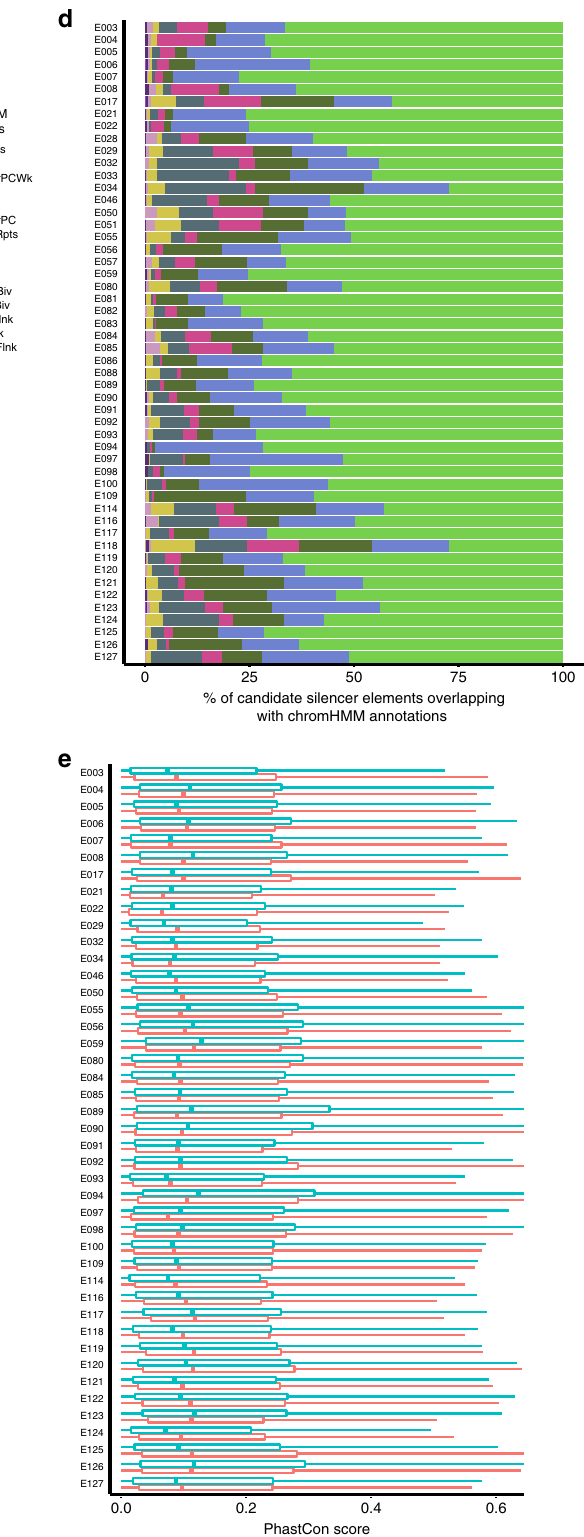
Fig. 4 Characteristics of candidate silencer elements. a Bar plot presenting the count of cell types enriched with TF motifs at candidate silencer elements across 52 cell types and tissues from Roadmap. b Heatmap of enrichment (-log( P -value)) of TF motifs at candidate silencer elements across 52 cell types relative to random genomic background. c Box plot showing the distribution of methylation levels at candidate silencer elements, DHS and active enhancers across 17 cell types. d Bar plot showing the distribution of chromHMM annotations of candidate silencer elements across 52 human cell types. e Box plot of PhastCon conservation scores (seven ways) for candidate silencers and active enhancers across 52 cell types. In the box plots, bounds of the box spans from 25 to 75% percentile, center line represents median, and whiskers visualize 5 and 95% of the data